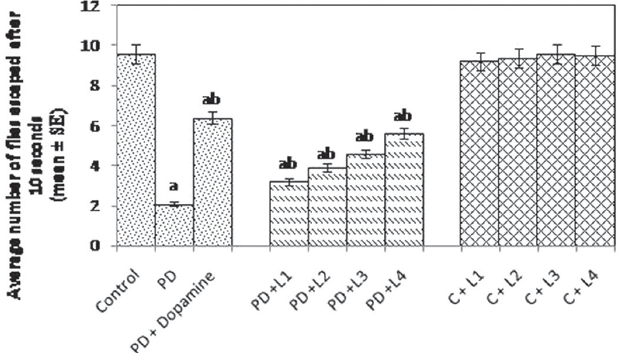
FIGURE 1 - Effect of luteolin on the climbing ability. [L1= 25 µM; L2= 50 µM; L3 = 75 µM; L4=100 µM; PD = PD flies; Dopamine=10-3 M]. The flies were allowed to feed on the diet supplemented with luteolin for 24 days and then assayed for climbing ability. The values are the mean of 5 assays. [a - significant at p<0.05 compared to control; b - significant at